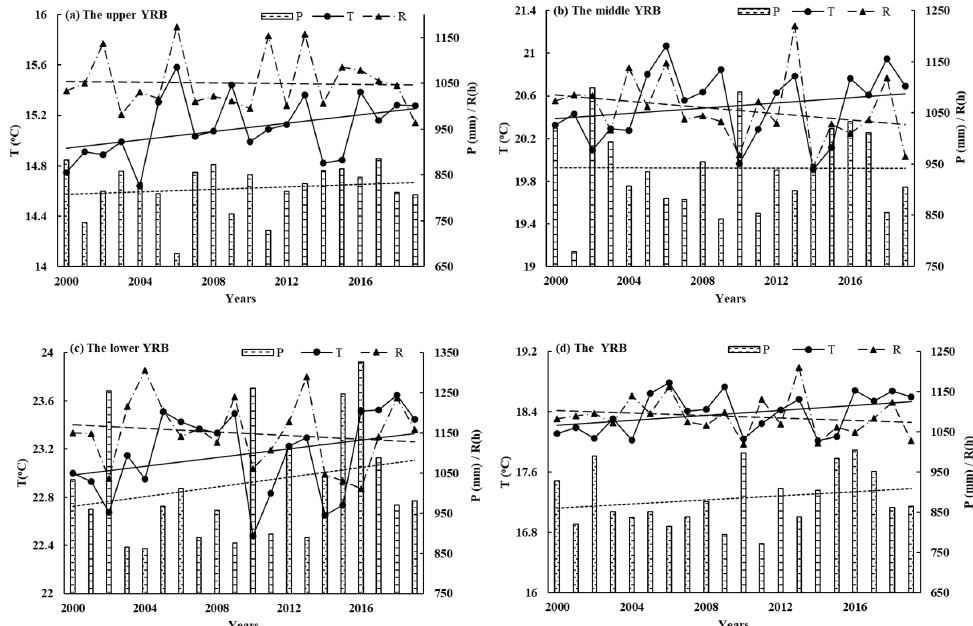
Figure 10. Changes in annual of T, P, and R in ( a ) the upper of Yangtze River Basin, ( b ) the middle of Yangtze River Basin, ( c ) the lower of Yangtze River Basin, and ( d ) the Yangtze River Basin. (T: temperature, P: precipitation, R: solar radiation).